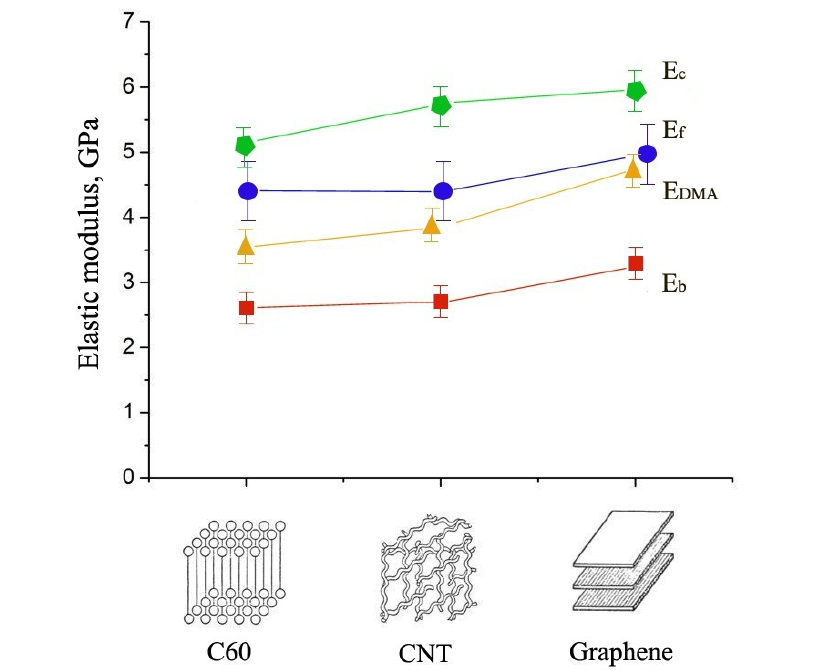
Figure 6. Elastic moduli of PS-based composites filled with carbon allotropes at the concentration of 5 wt%. Moduli were obtained at four static and dynamic tests: tensile ( E b ), three-point bending ( E f ), DMA ( E DMA ), and ultrasonic ( E c